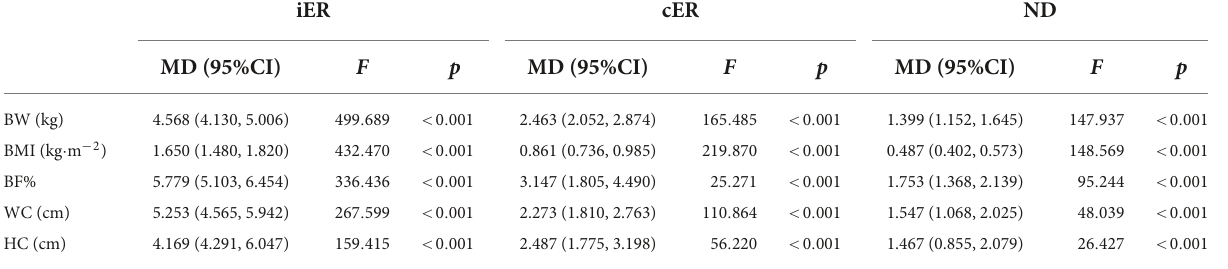
TABLE 4 Body composition and anthropometric parameters before and after intervention.